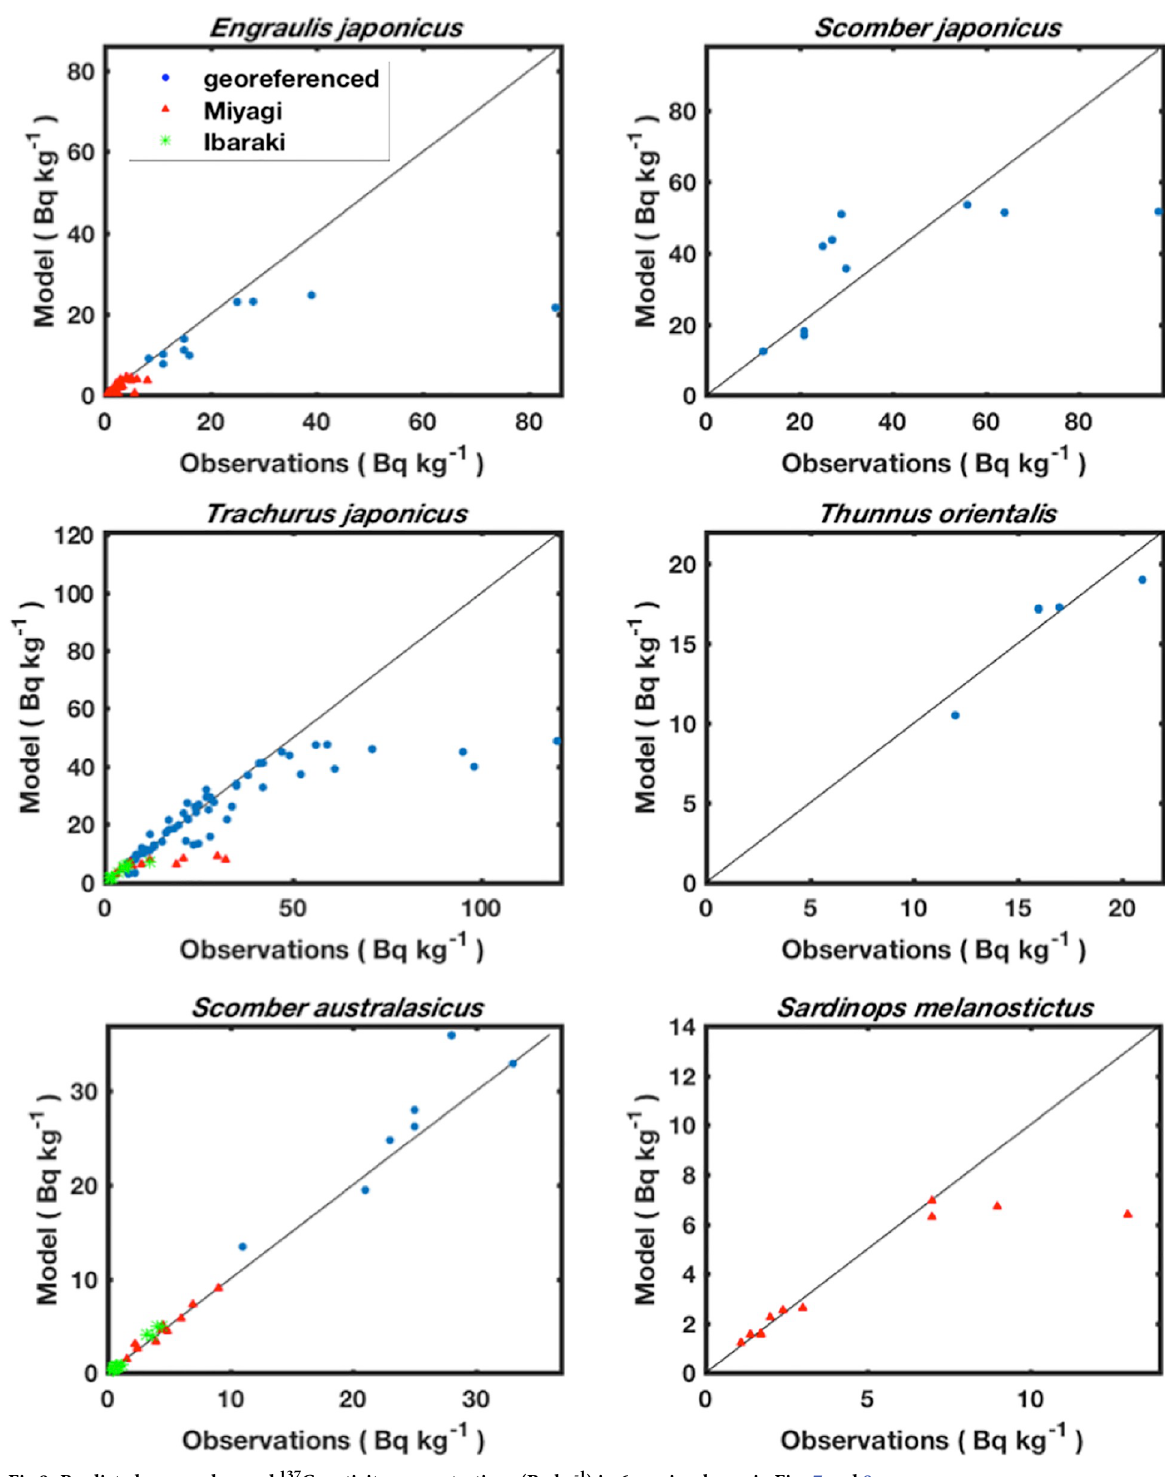
Fig 9. Predicted versus observed 137 Cs activity concentrations (Bq kg -1 ) in 6 species shown in Figs 7 and 8.